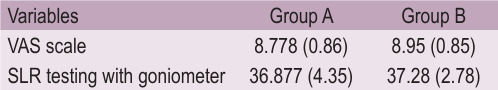
TABLE 3. Between-group change score before therapy